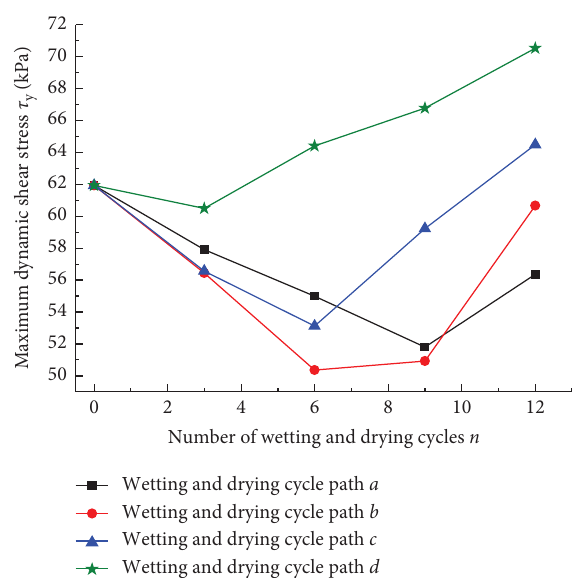
Figure 6: Relationship between τ